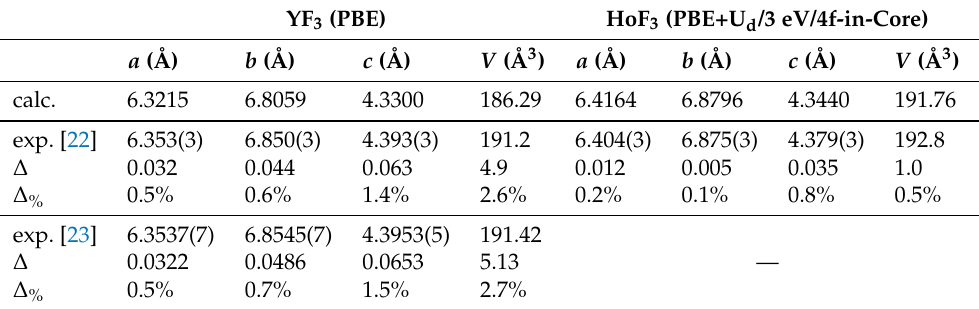
Figure 1. The orthorhombic unit cell of β -YF 3 with Pnma symmetry. Lattice constants are given in Table 1. The distorted tricapped trigonal prisms formed by nine fluorides (green) around each yttrium (cyan) are visualized by transparent, cyan planes. Table 1. Comparison of the relaxed unit cells to experiment including standard deviation in paren- theses [22,23]. Given is the absolute difference ( ∆ ), as well as the deviation from experiment in percentage ( ∆ %